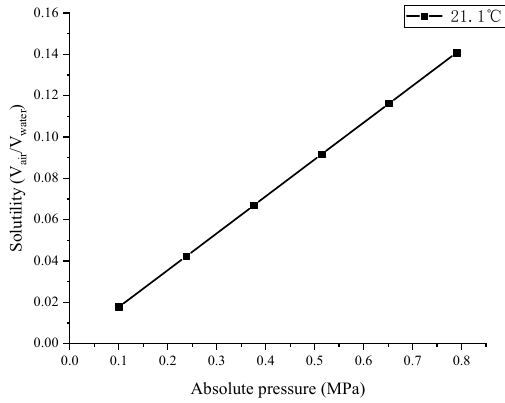
Figure 8. Solubility at different pressures.